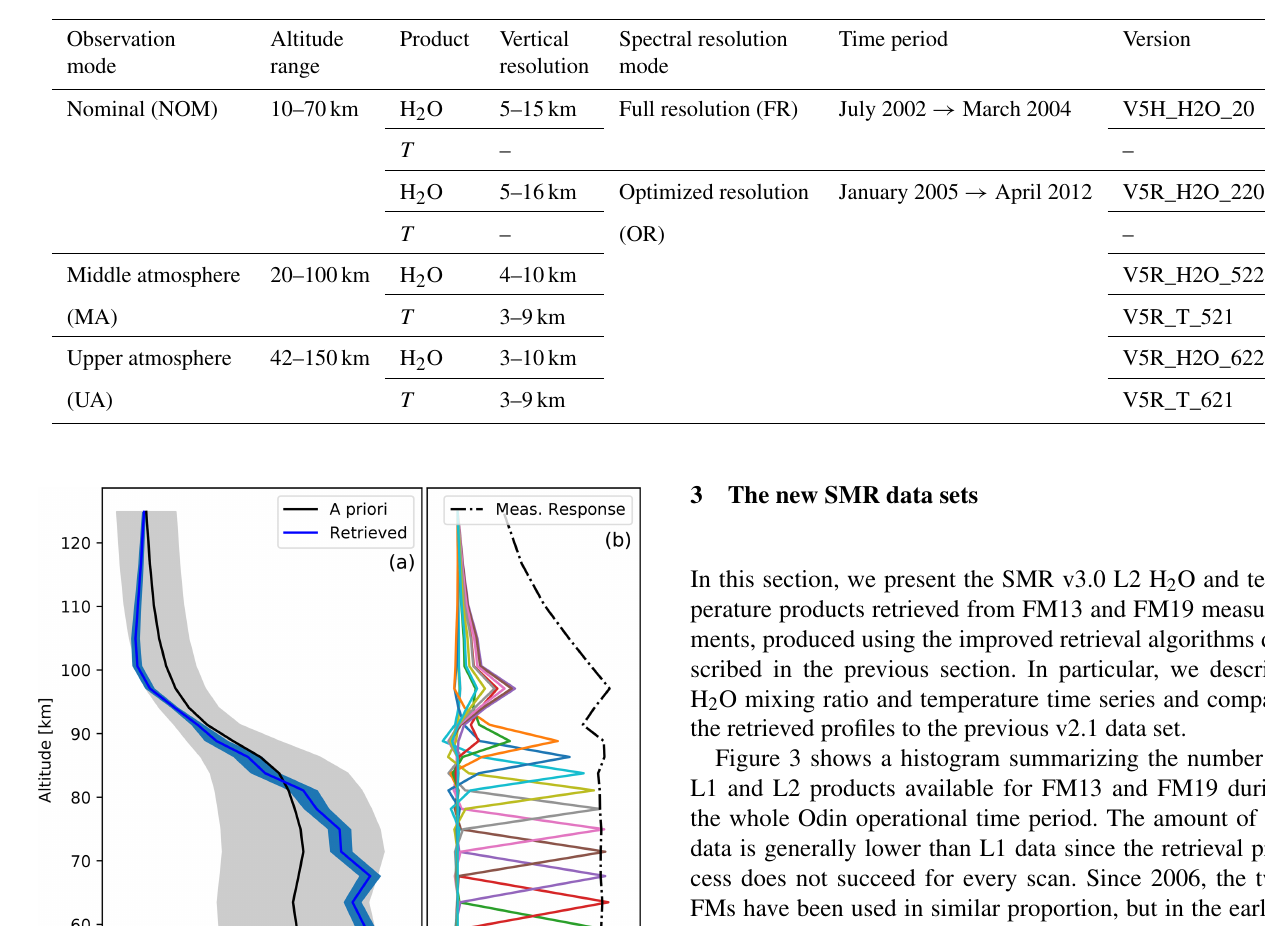
Table 2. Characteristics of the MIPAS H 2 O and temperature data sets used for comparison. Vertical resolutions refer to the observations in the altitude range 40–100km considered in this study.